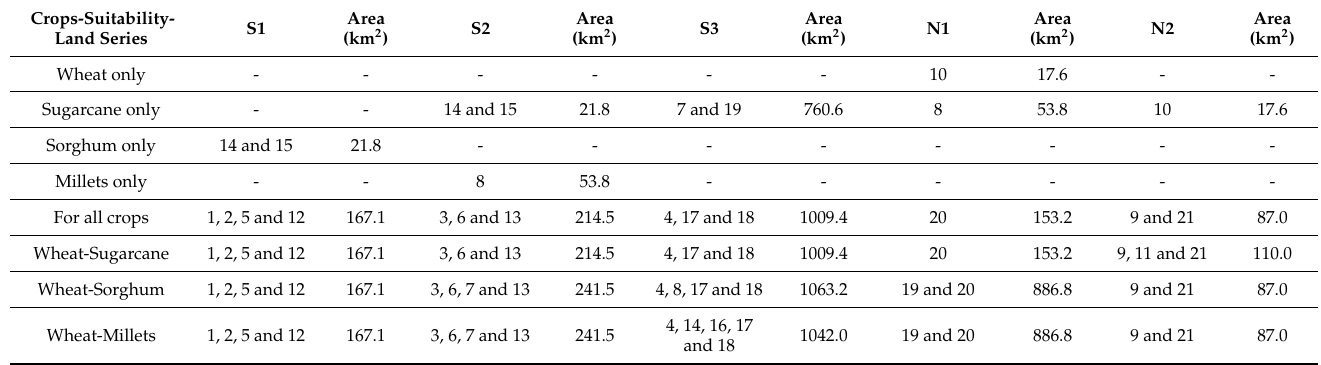
Table 6. The land series corresponding to crop and suitability class for a different